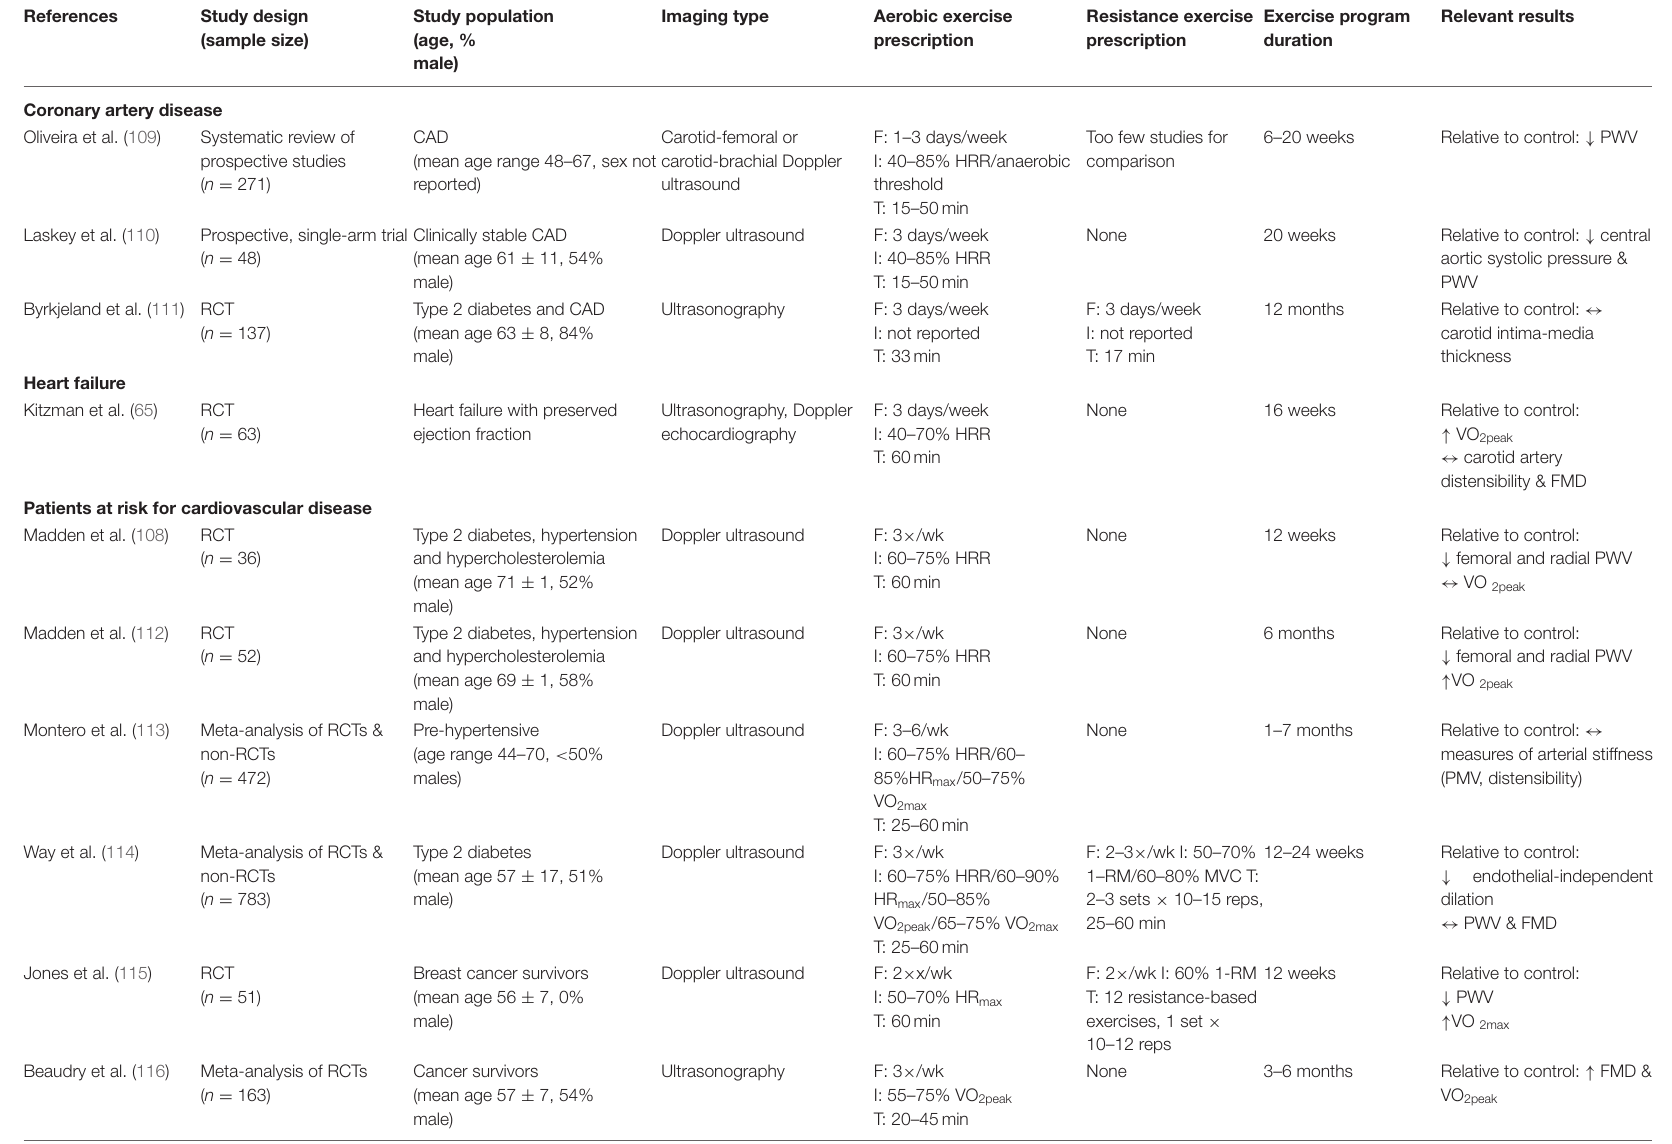
TABLE 2 | Characteristics of the imaging studies reporting on the vascular effects of exercise